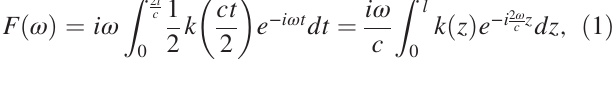
k ð z Þ ¼ k ð z Þ (blue) where linnecar